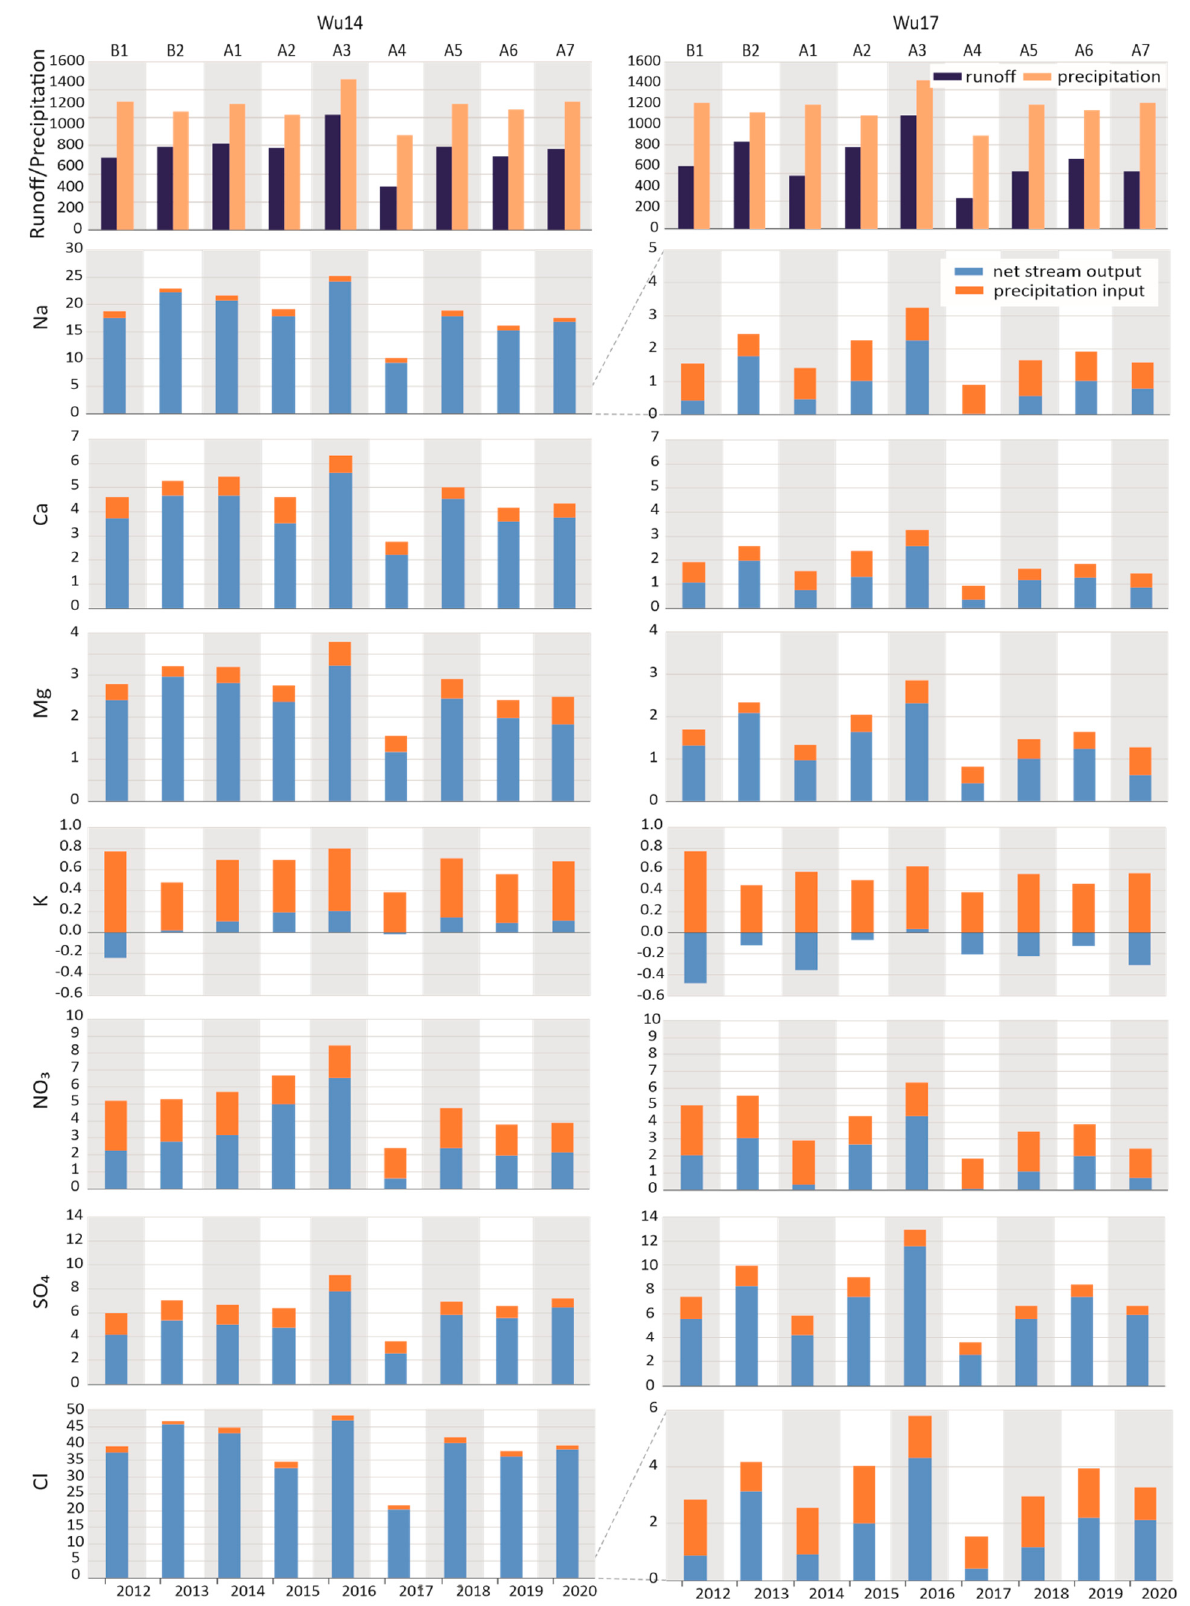
Figure 8. Annual solute fluxes (t km − 2 a − 1 ) in stream water and precipitation together with runoff (mm) and precipitation (mm) in the partially deforested Wüstebach catchment (Wu14) and the control catchment (Wu17).